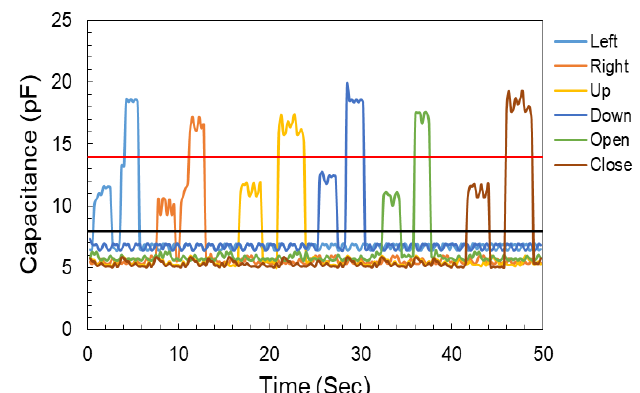
Figure 4. CPS, keypad-based HMI capacitance response to no touch, low-pressure touch, and high-pressure touch conditions.